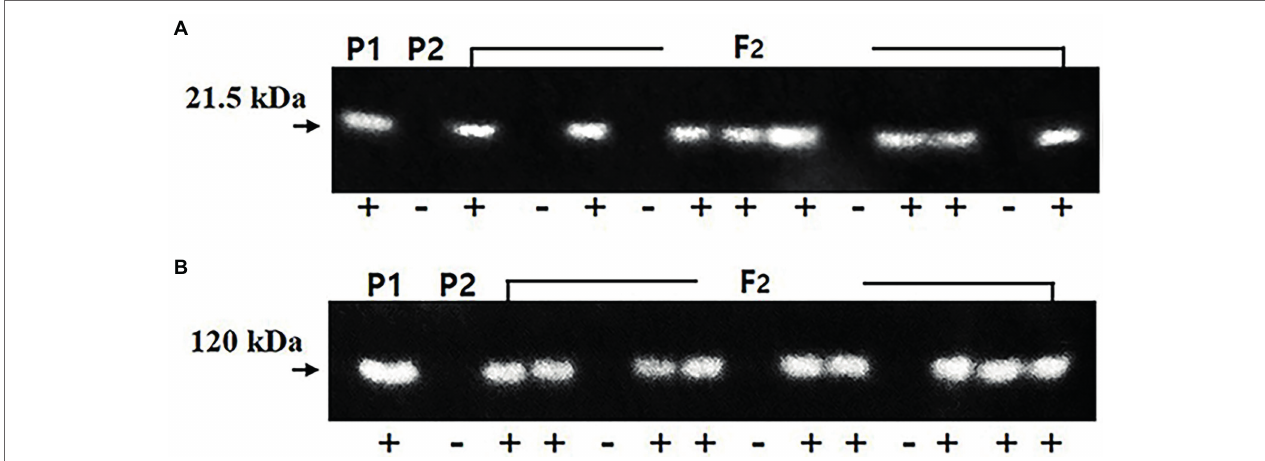
FIGURE 2 | Segregation of KTI (A) and lectin (B) proteins in the parents and F 2 seeds. Arrows indicate the KTI protein of 21.5 kDa and lectin protein of 120 kDa. P1: lox1lox2lox3/lox1lox2lox3 - Ti/Ti - Le/Le - cgy1/cgy1 - rs2/rs2 genotype, P2: lox1lox2lox3/lox1lox2lox3 - ti/ti - le/le - cgy1/cgy1 - Rs2/Rs2 genotype. +, − : presence and absence of KTI and lectin